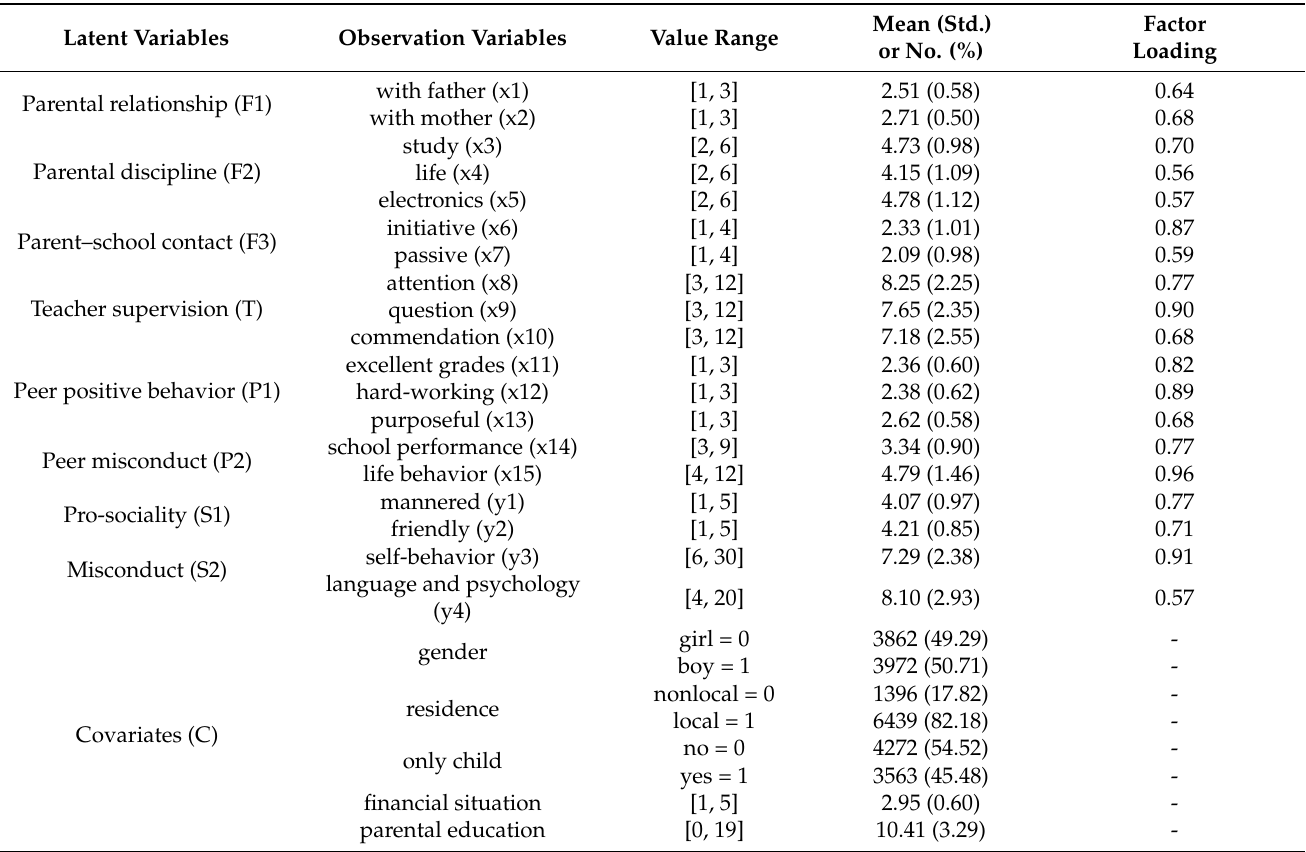
Table 1. Definition and description of variables, n = 7835.